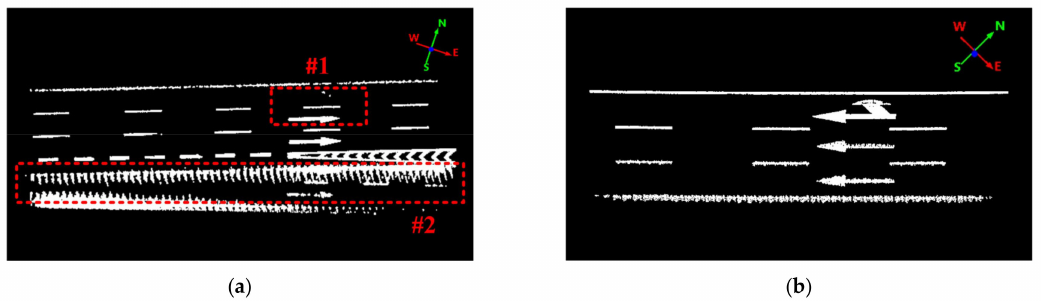
Figure 8. Road markings extracted by Yu’s method [16]: ( a ) From dataset I; ( b ) from dataset